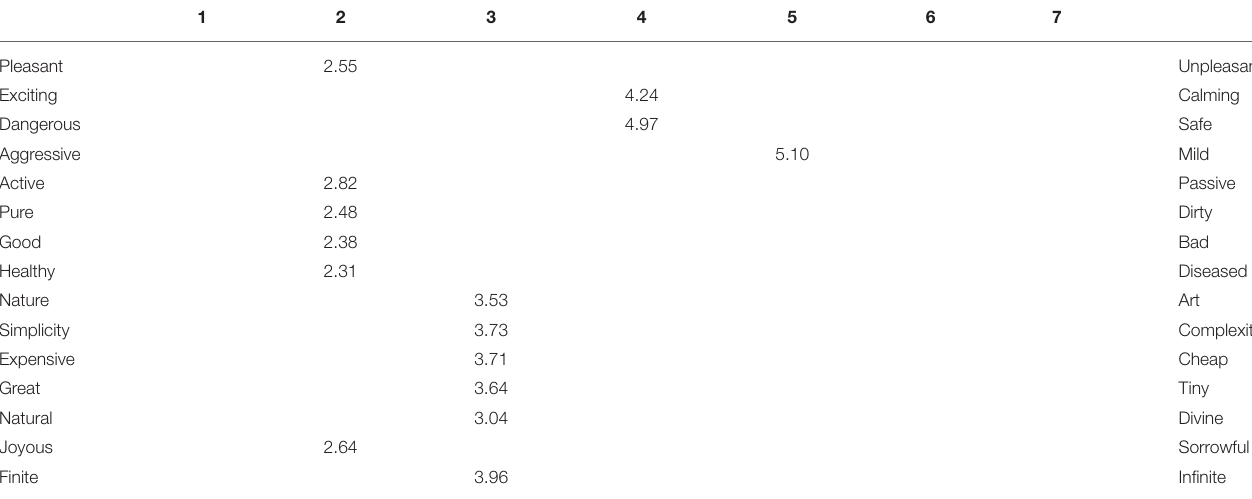
TABLE 2 | The concept of beauty semantic differential